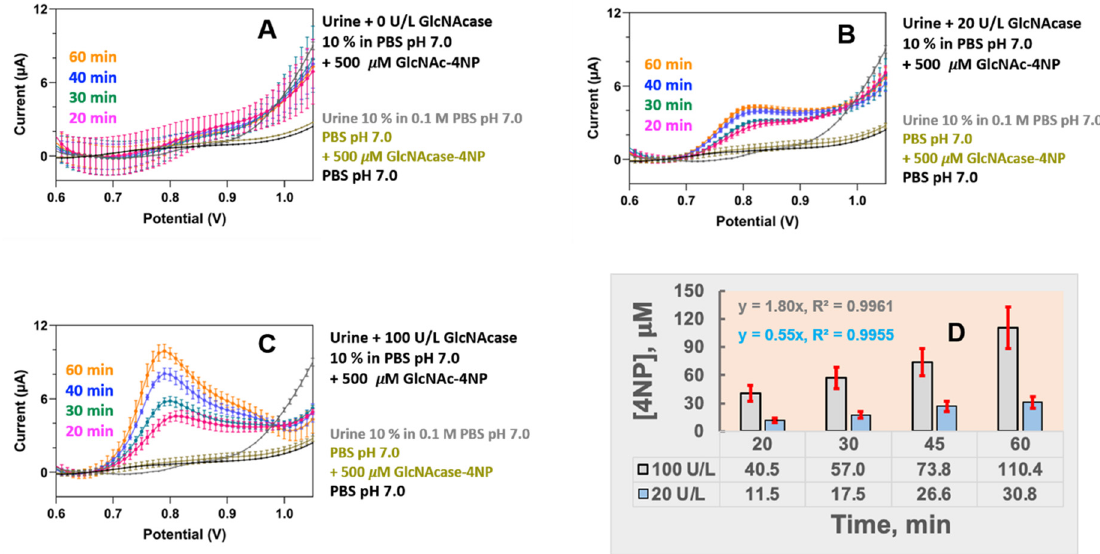
Figure 5. Assessment of model samples in 0.1 M PBS, pH 7.0: unsupplemented urine ( A ), urine with a medium (20 U/L, ( B) ) and urine with a high (100 U/L, ( C )) concentration of the biomarker GlcNAcase. A total of 300 μ L of the urine samples was added to 2700 μ L of 0.1 M PBS, pH 7.0 containing 0.5 mM GlcNAc-4NP. 4NP differential pulse voltammograms (DPVs), recorded 20, 30, 45 and 60 min after trial start, visualized 4NP release through the action of GlcNAcase on the substrate as progressively increasing anodic peak currents. ( D ) Bar chart plot of anodic 4NP peak current magnitudes, i p , as a function of catalytic time GlcNAc-4NP. Insets are the slopes of regression lines through plots of the i p values as listed below the x-axes vs. corresponding reaction time. The width of the error bars of all data points is ±20%, which was the observed worst-case scenario throughout all individual measurements of the triplicate trial with actual urine; average percentage standard deviation was (10 ± 6)%. Parameters for DPV acquisition were as listed in Figure 2.